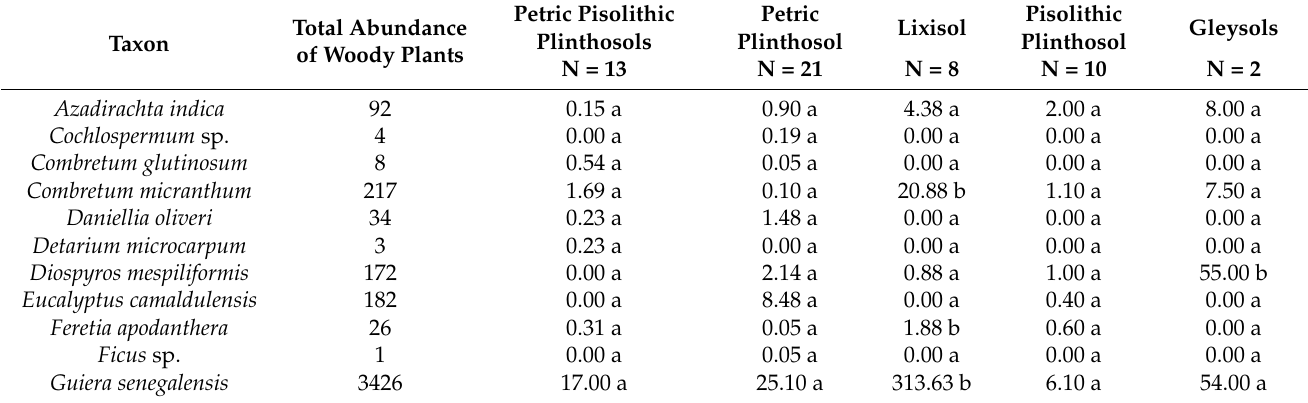
Table 4. Statistical comparison of the mean number of individuals of existing woody